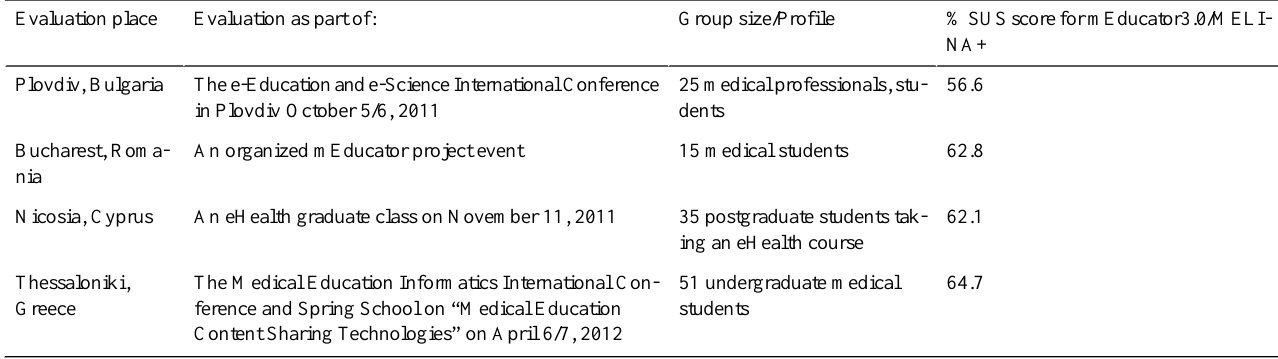
Table 1. SUS scores for the mEducator3.0 MELINA+ instantiation in four case studies.